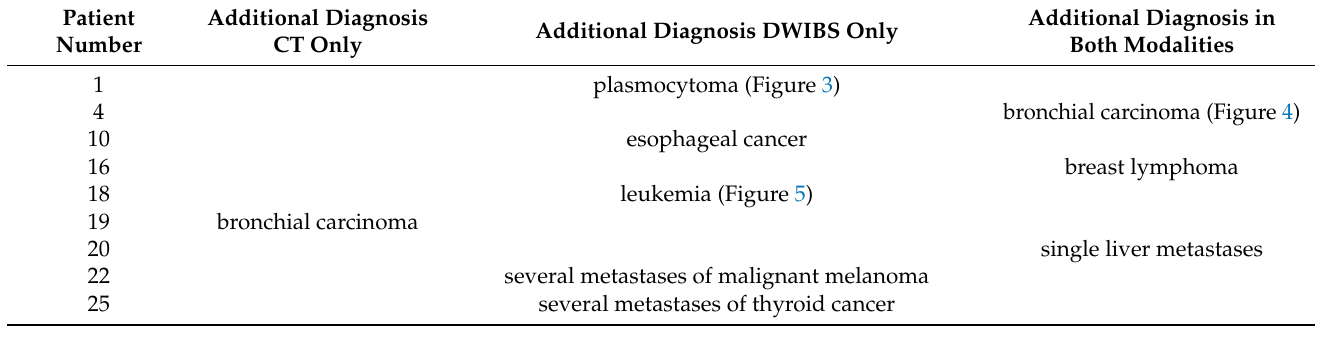
Table 3. Additional diagnosis made with computed tomography (CT) and/or whole-body DWIBS MRI in the routine work-up of pretherapeutic staging.